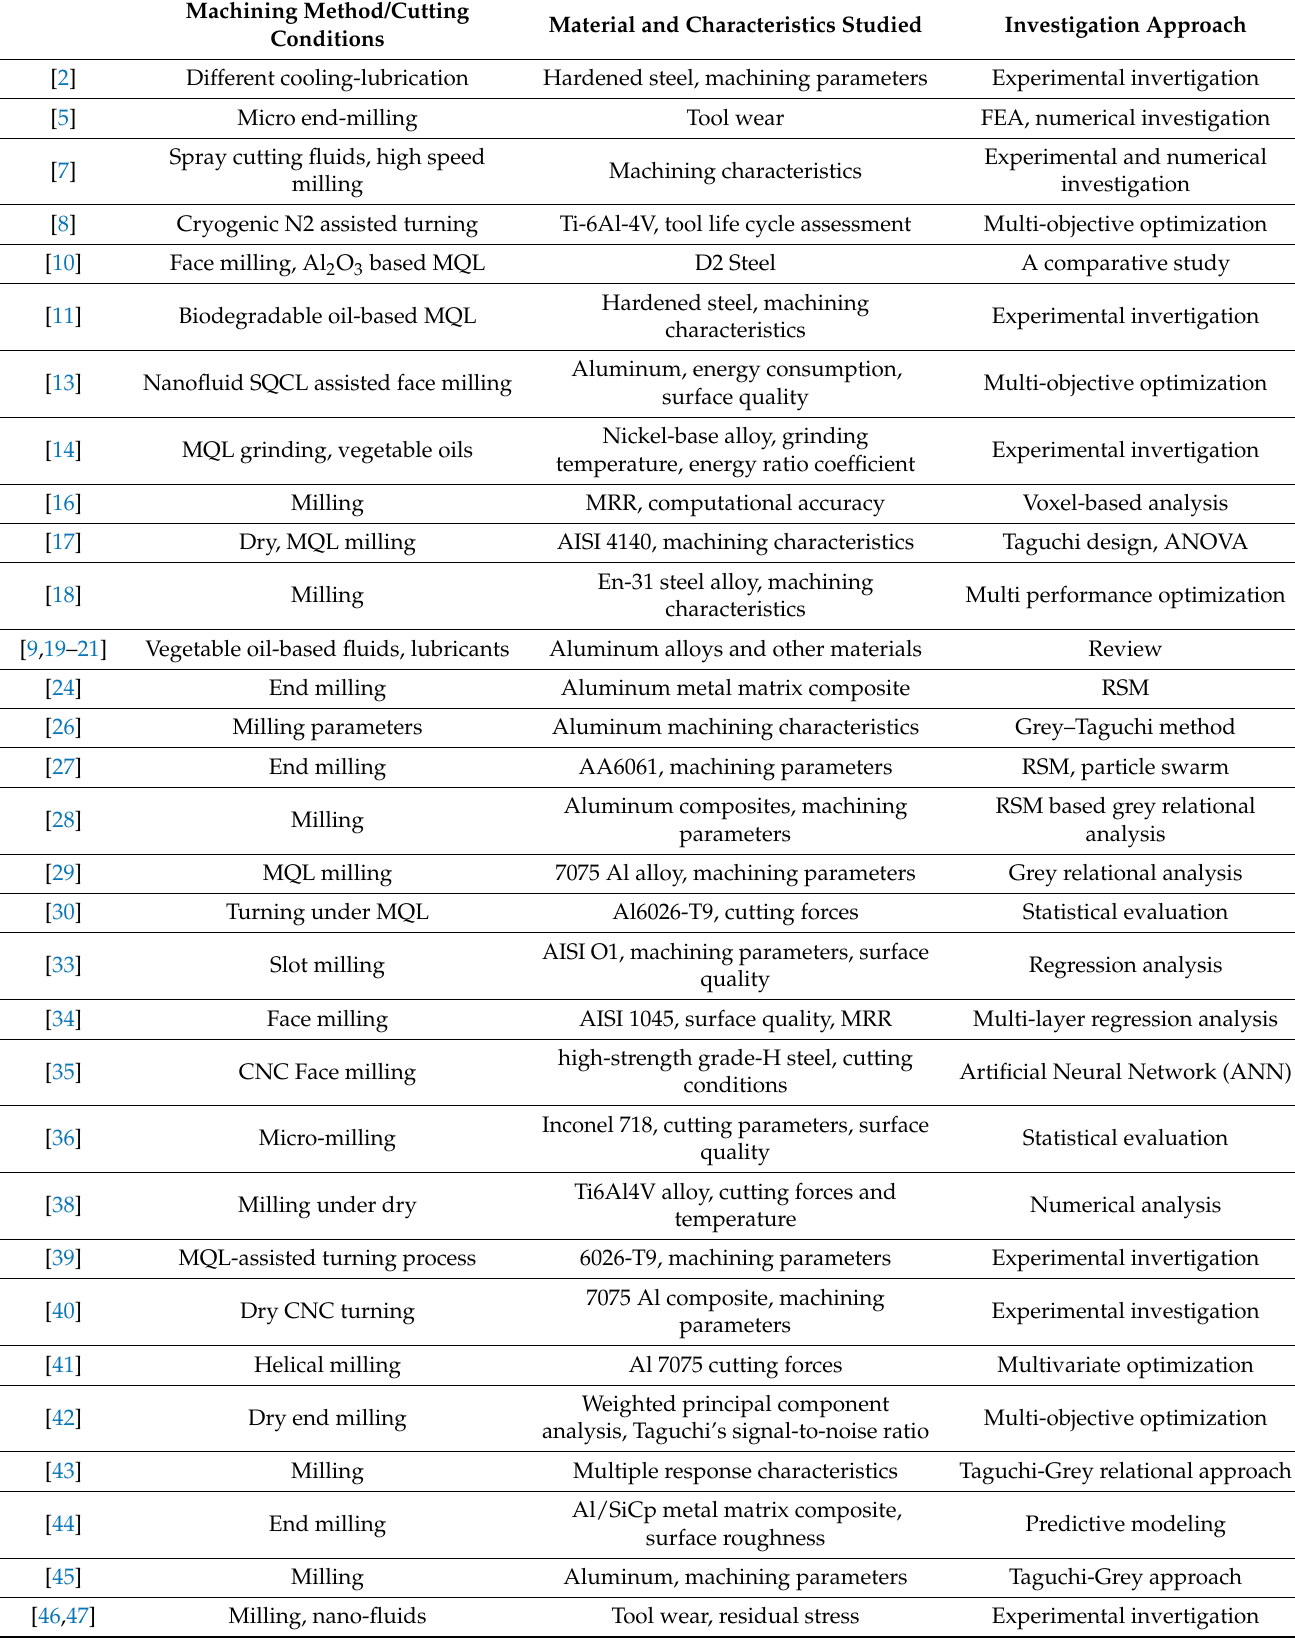
Table 1. A general summary of related published studies (cutting conditions and machining performance